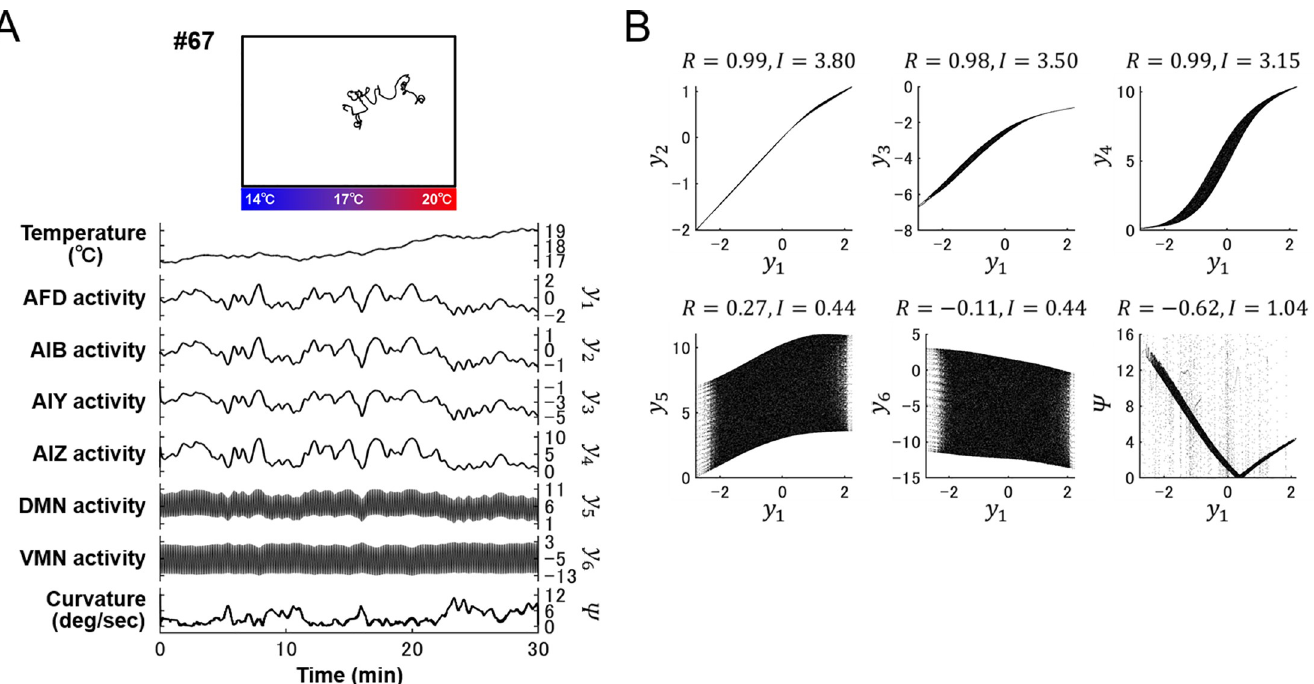
Fig 7. Activity of a thermosensory neuron and interneurons shows strong correlations. (A) Representative trajectory of a model worm (upper panel) generated through the neuroanatomical model with a representative parameter set (#67). The time series of temperature sensed by the worm, activity of individual neurons ( y 1 and steering curvature of locomotion ( C ) are represented in lower panels. (B) Scatter plots of AFD activity y 1 versus activity of other neurons y 2 − 6 or steering curvature C obtained from 100 model worms. Correlation coefficients ( R ) and mutual information ( I ) among the time series are measured (see Materials and Methods) and plotted in the